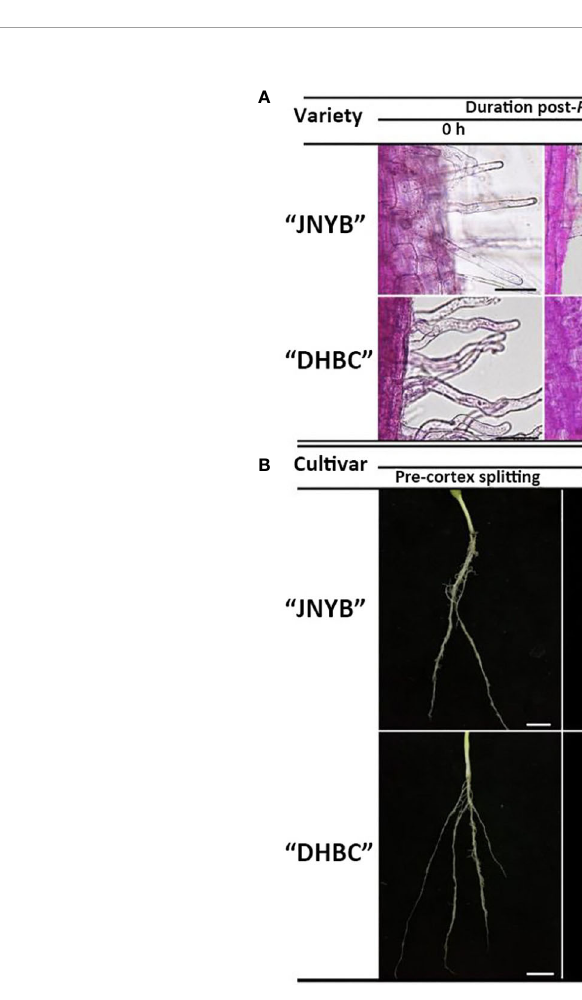
FIGURE 2 Growth of P. brassicae within the root hair of radish 0, 24, and 72 h after inoculation with resting spores (A) and the clubroot disease incidence in radish tap root in the pre-cortex splitting, cortex splitting, and post-cortex splitting stages (B) Black arrows in (A) indicate spores and zoosporangia., White arrows in (B) indicate swelling roots. Scale bar in (A) , (B) equals to 100 m m and 1 cm,